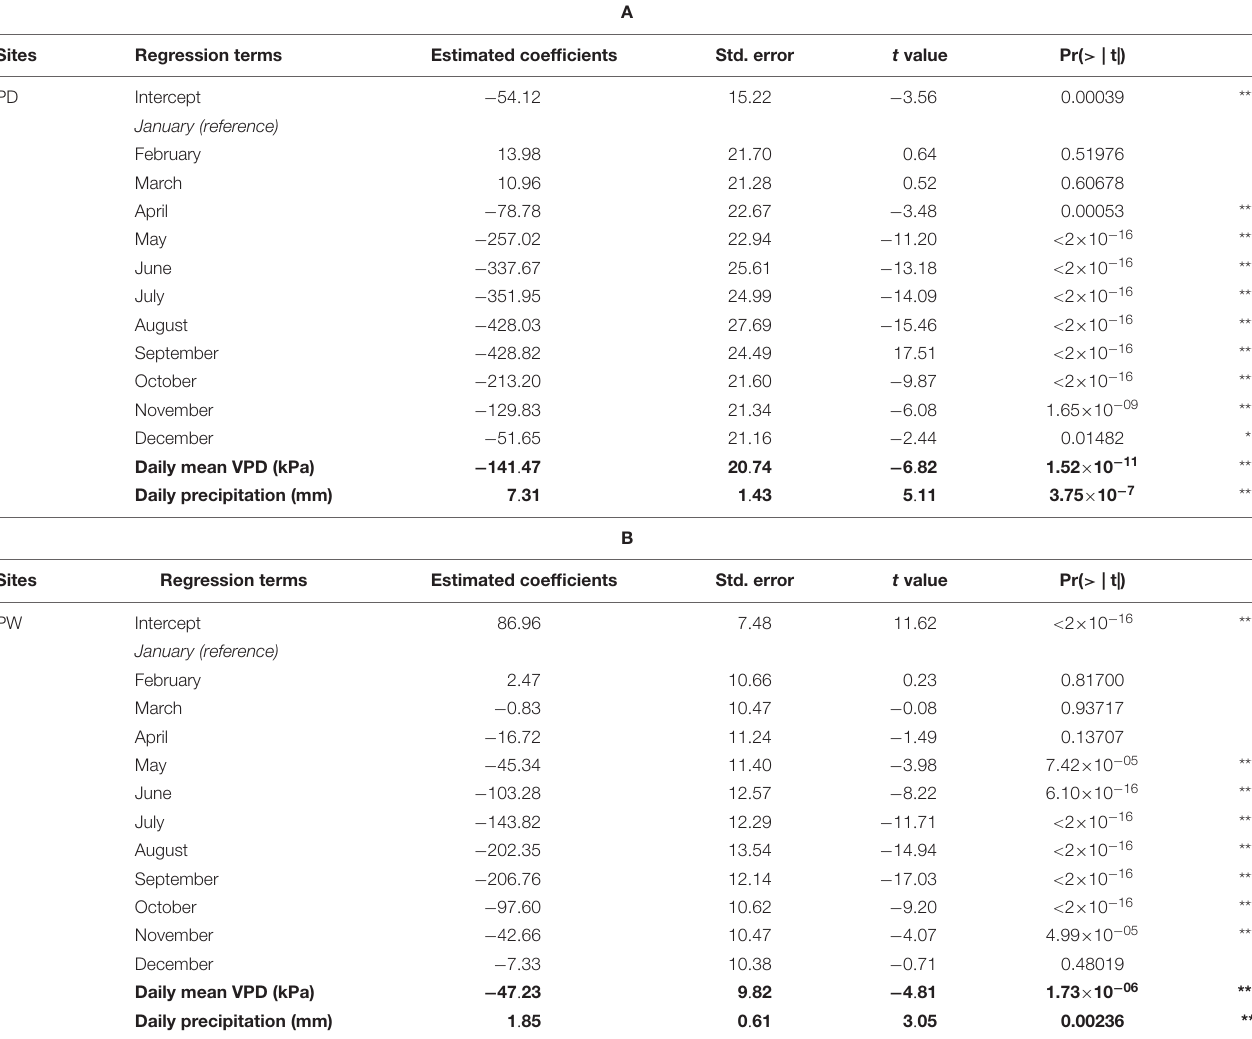
TABLE 2 | Multiple linear regression of water level at (A) PD and (B)